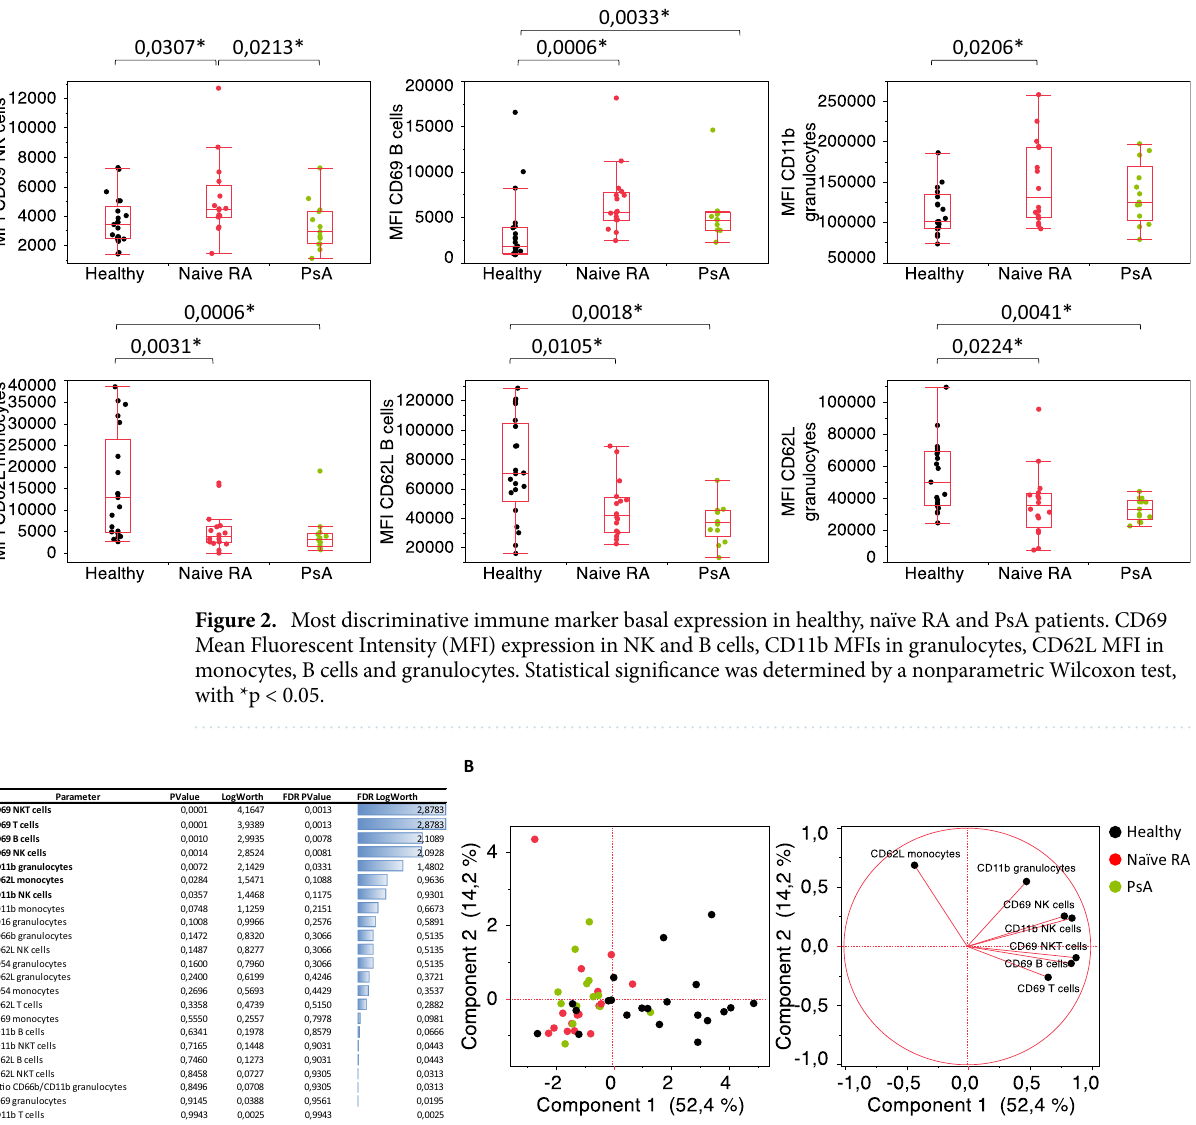
Figure 3. Multivariate analysis of all parameters considered for the LPS condition from heathy donors, naïve RA and PsA patients. ( A ) Response screen of Stimulation indexes (Stim. Index) ranking all parameters according to its discriminative power to distinguish healthy from naïve RA patients after LPS stimulation. ( B ) Principal component analysis were only most discriminant features having a p-value < 0.05 were included in the